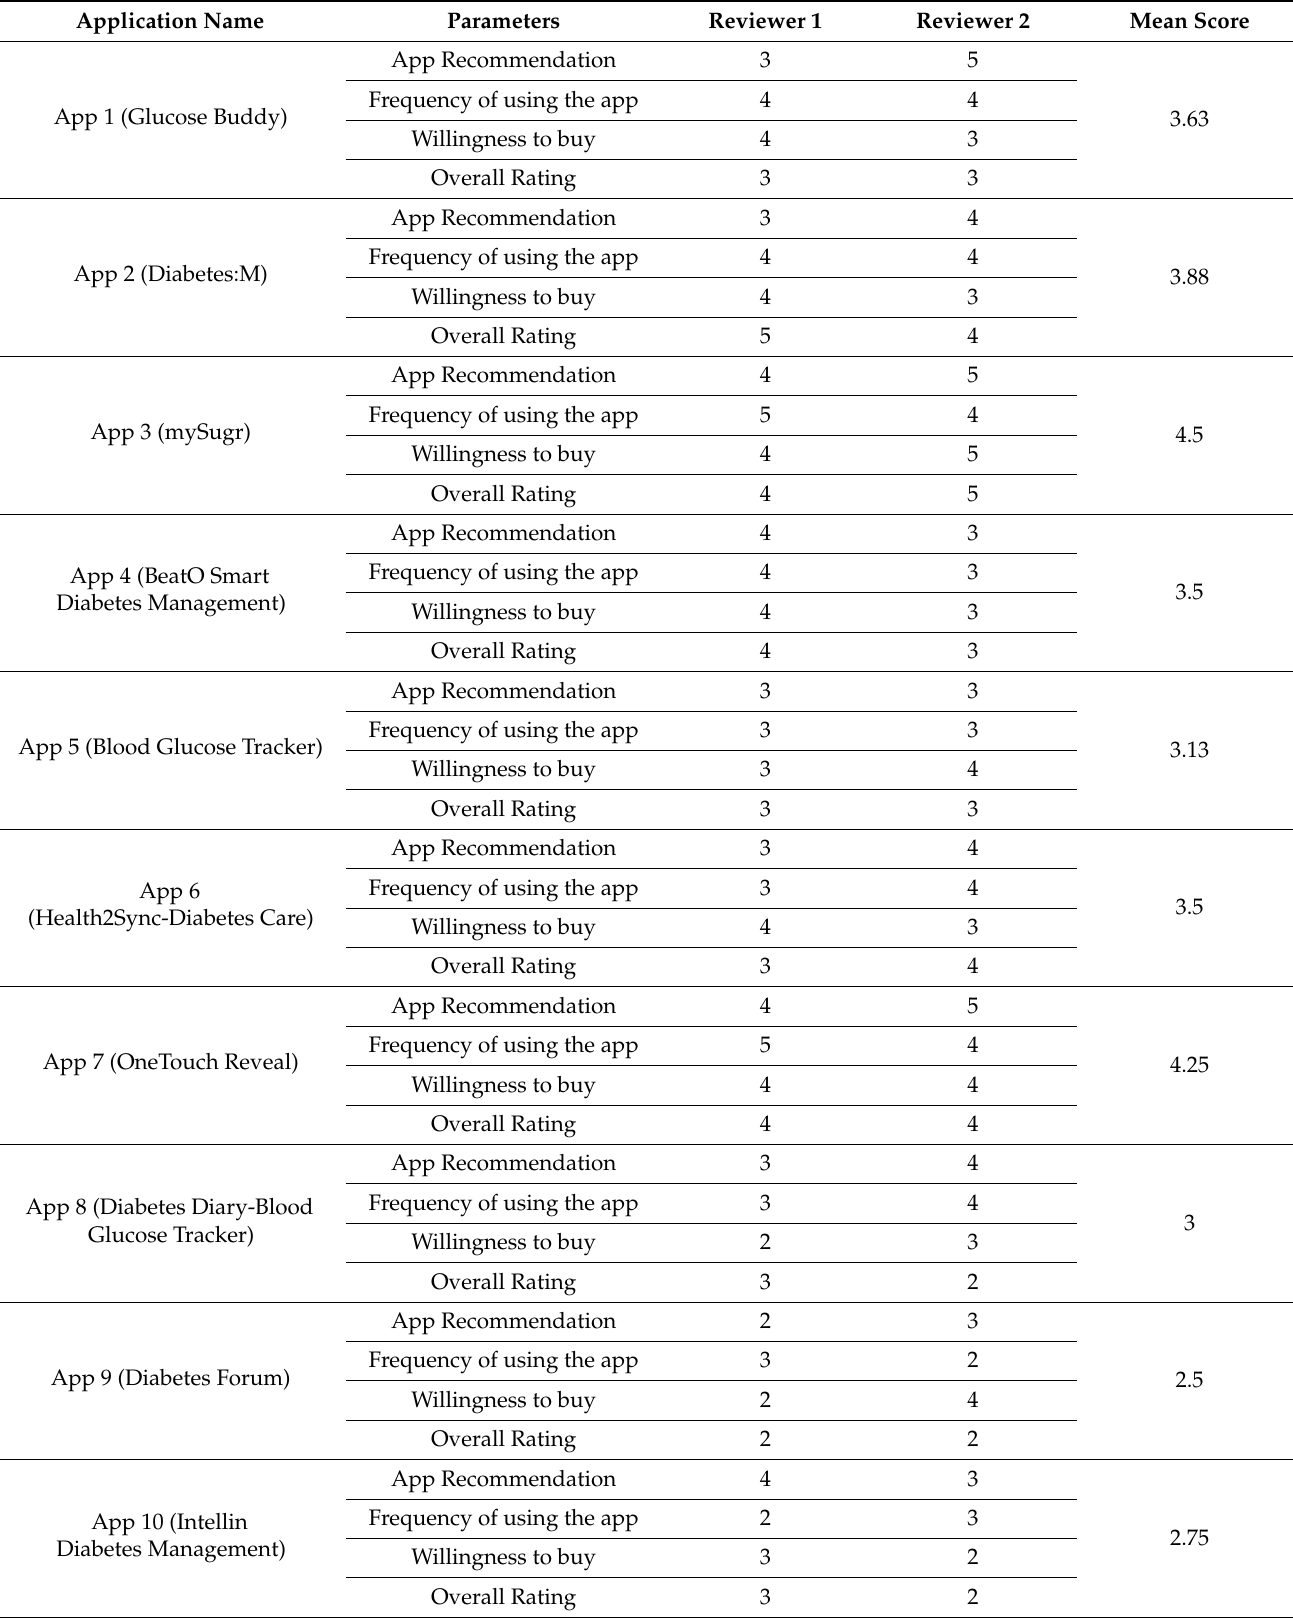
Table 3. Category II, including the application’s subjective quality mean